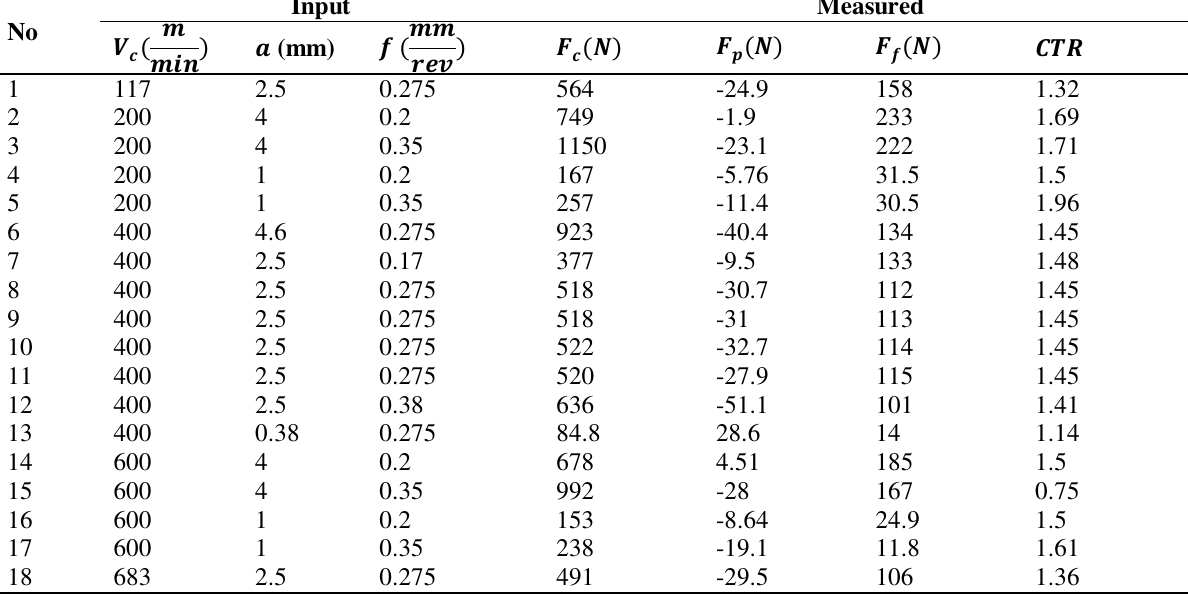
Machining experimental results taken from Santos, et al. [5] No